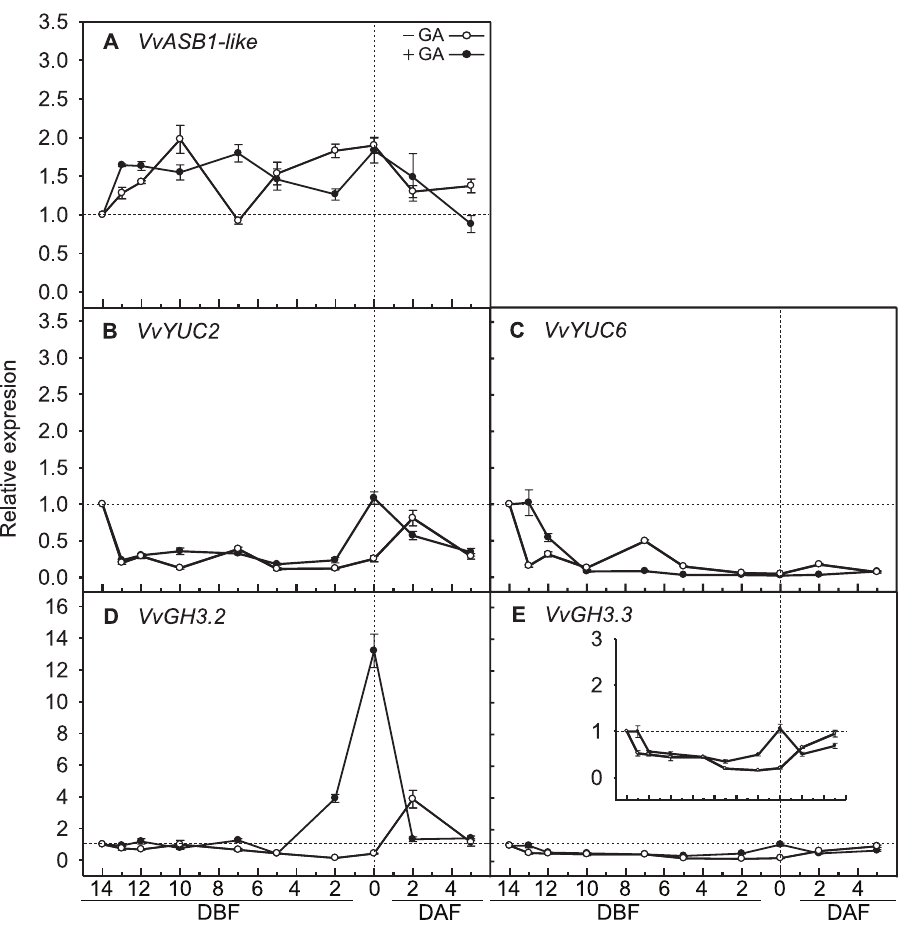
Figure 3. Transcriptional changes in auxin biosynthesis genes (A, B, and C) and early auxin-responsive genes (D and E). ( A ) VvASB1- like , ( B ) VvYUC2 , ( C ) VvYUC6 , ( D ) VvGH3.2 , and ( E ) VvGH3.3 in grapevine inflorescences with and without GA application. The expression level of VvGH3.3 is magnified in the insets. DAF, days after full bloom; DBF, days before full bloom. Quantitative reverse transcription-PCR was performed to measure the expression level of each gene using the comparative C T method. After normalization of each sample to the expression of the internal control VvActin1 , the expression of each gene relative to the 14 DBF sample was calculated. Bars are standard errors of the means from three independent